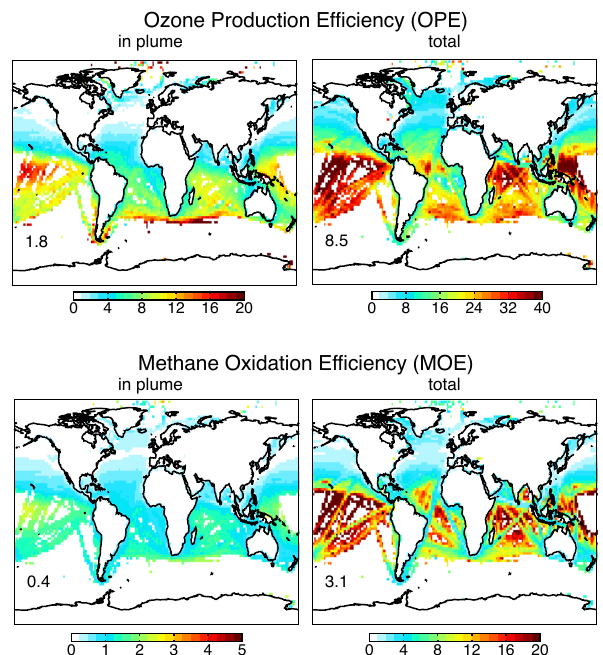
Figure 2. Time-averaged ozone production efficiency (top row) and methane oxidation efficiency (bottom row) for marginal increases in ship NO x emissions within the sub-grid plume (left panels) and total (plume plus grid chemistry, right panels). Values are shown from the CTM with parametric plume chemistry only where ship NO x emis- sions exceed 10 4 molecm − 2 s − 1 . Inset numbers give global aver-